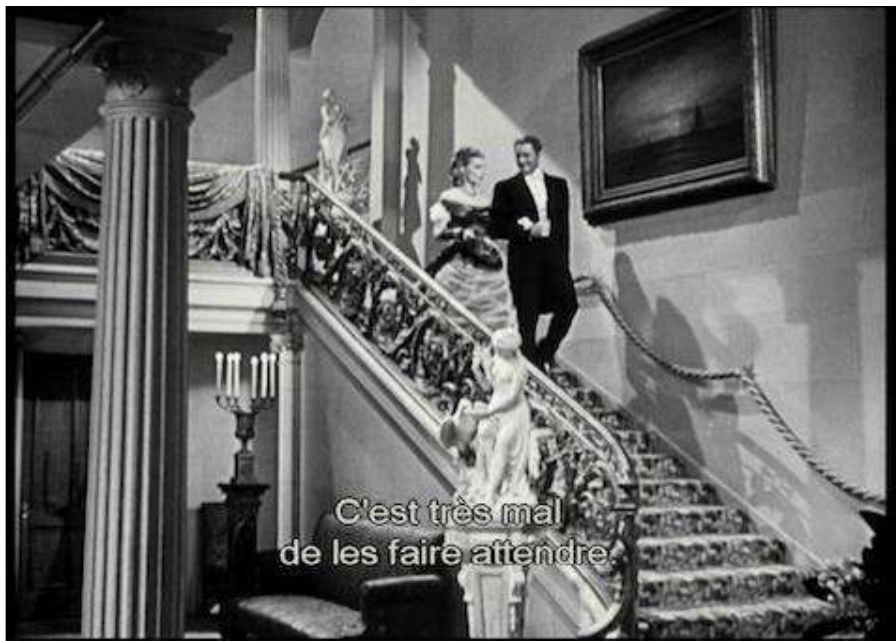
Figure 21: The staircase in Silver River